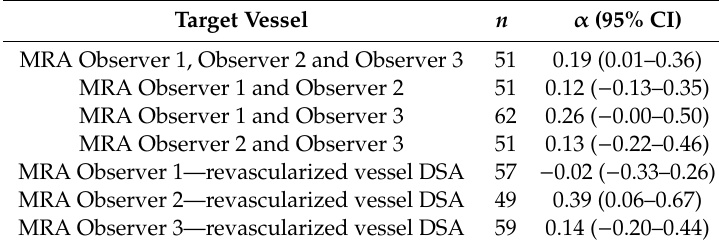
Table 3. Krippendor ff ’s alpha (95% CI) interobserver agreement on the target vessel assessed for MRA and versus actually revascularized